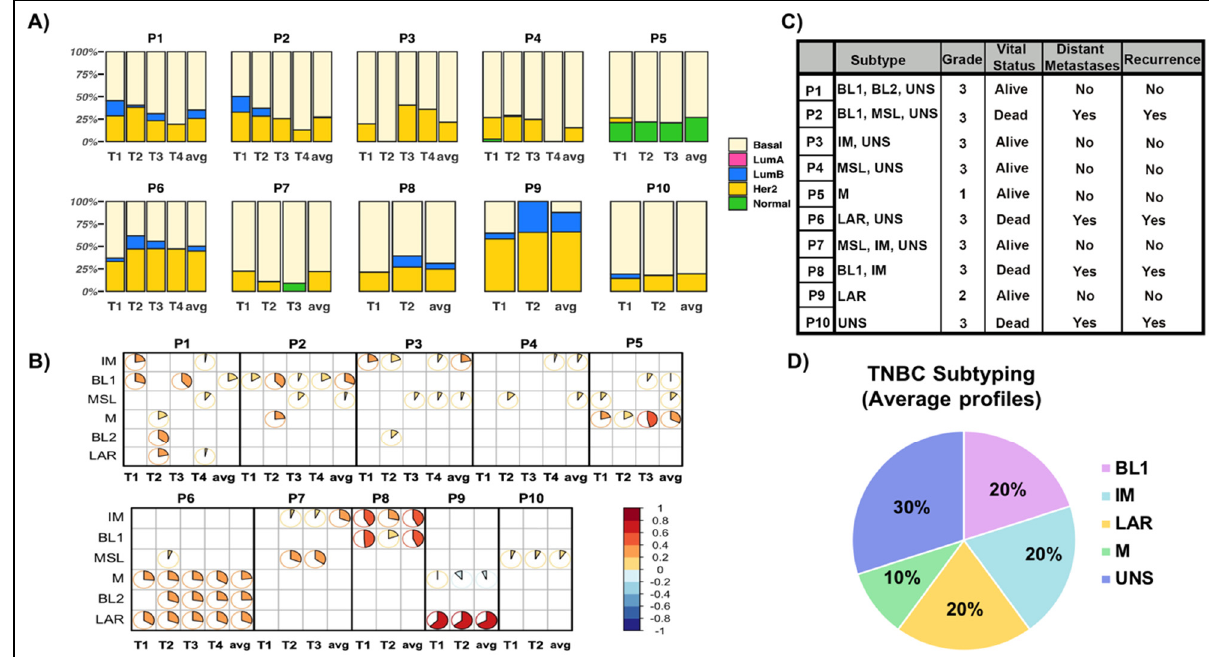
Figure 4. Molecular classification differs among different regions of the same tumor. ( A ) PAM50 subtyping. For each patient (denoted by P) and tumor regions (denoted by T) and average gene expression over regions (denoted by avg), PAM50 subtyping results were expressed as probability to classify into each of the five subtypes: basal-like (basal), luminal A (LumA), luminal B (LumB), HER2-enriched (HER2) and normal-like (normal). ( B ) TNBC subtyping. Correlogram of TNBC subtyping results for each tumor region and average (over regions); significant ( p ≤ 0.05) results are shown. Each pie chart represents the correlation between the tumor sample with each TNBC subtype, with the direction of correlation as positive (red) and negative (blue). ( C ) Summary of regional TNBC subtype classifications combined with patient and tumor characteristics. BL1: Basal-like 1; IM: Immunomodulatory; LAR: Luminal androgen receptor; M: Mesenchymal; UNS: Unspecified group. ( D ) TNBC subtyping assignment based on mean (over regions) gene expression.